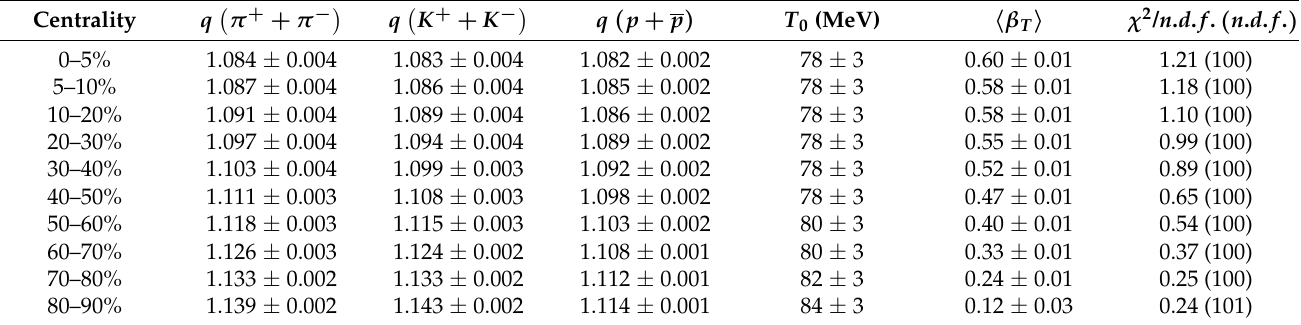
Table 2. The results obtained from combined minimum χ 2 fits with thermodynamically consistent Tsallis function with transverse flow (Equation (5)) of midrapidity p T spectra of particles in Pb + Pb √ s nn = 2.76 TeV. n.d.f. denotes the number of degrees of freedom. collisions at